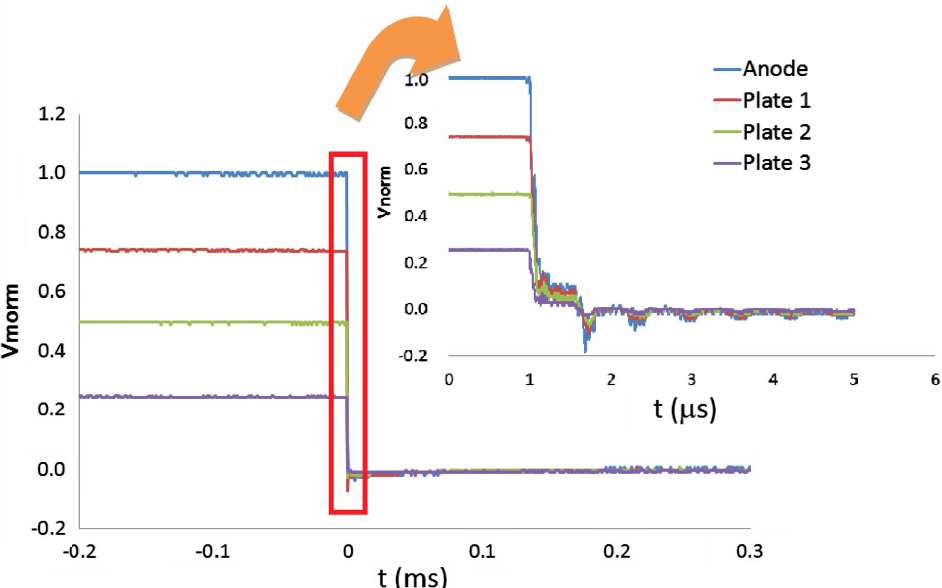
FIG. 15. Voltage waveforms measured at the anode and the intermediate electrodes around the turn-off timing. Here, the voltage is normalized by the anode voltage at the flattop. Expanded waveforms around the falling edge of the voltage pulse are also shown in the upper